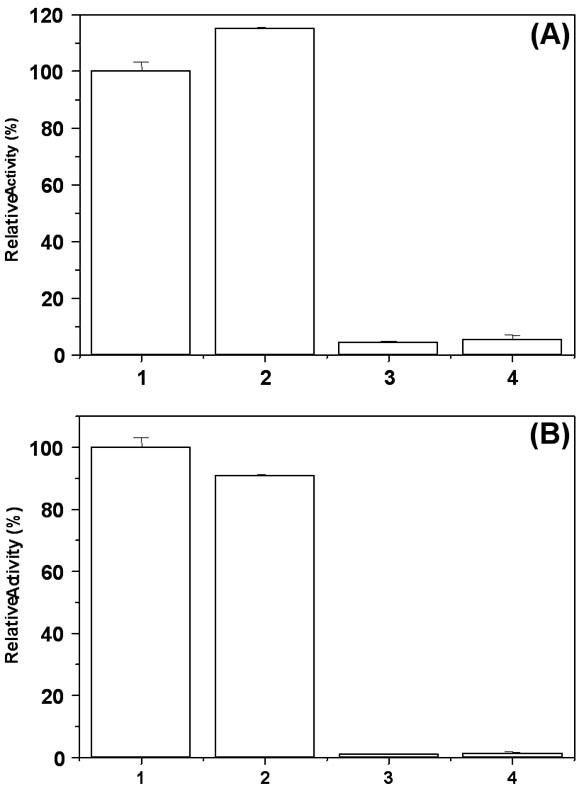
Cations influence enzymatic activity of both MtαIPMS and the TIM barrel domain. Effect of KCl, MgCl2, ZnCl2 or CdCl2 on enzymatic activity of MtαIPMS (Panel A) and the catalytic TIM barrel Domain (Panel B). In both the panels the bars 1 to 4 represent samples of protein in presence of 20 mM KCl, 20 mM KCl + 5 mM MgCl2, 20 mM KCl + 5 mM MgCl2 +2 mM ZnCl2 and 20 mM KCl + 5 mM MgCl2 + 2 mM CdCl2, respectively. The data is represented as percent activity with the activity of the protein in presence of 20 mM KCl taken as 100%. The data is represented as mean ± SD of three values.